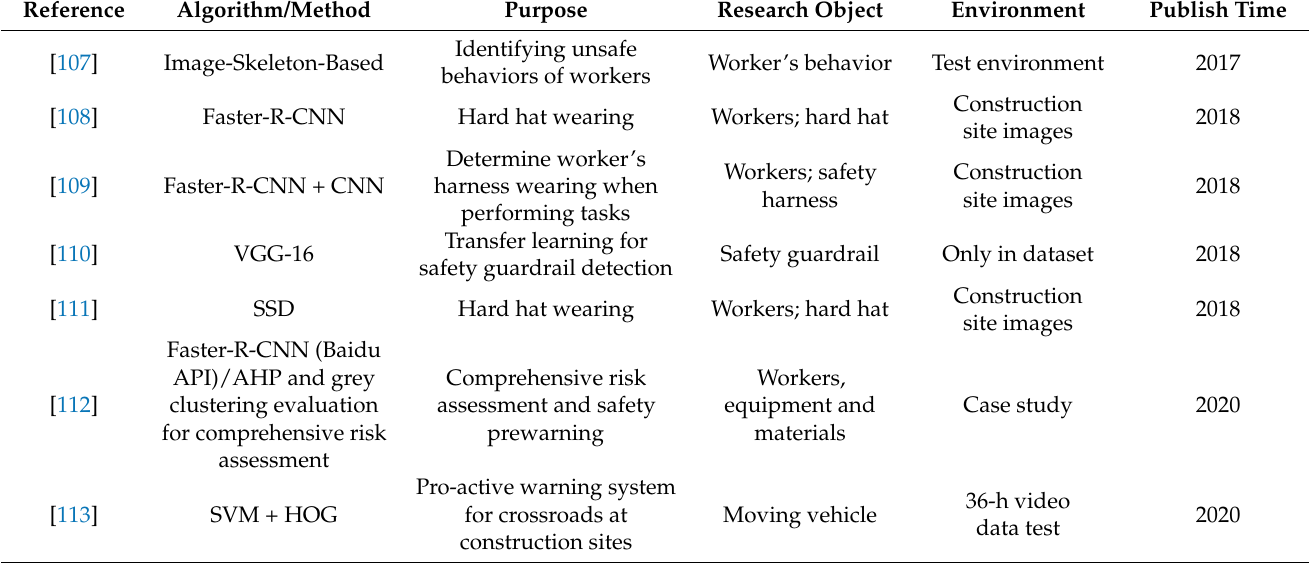
Table 8. Computer vision applications in safety